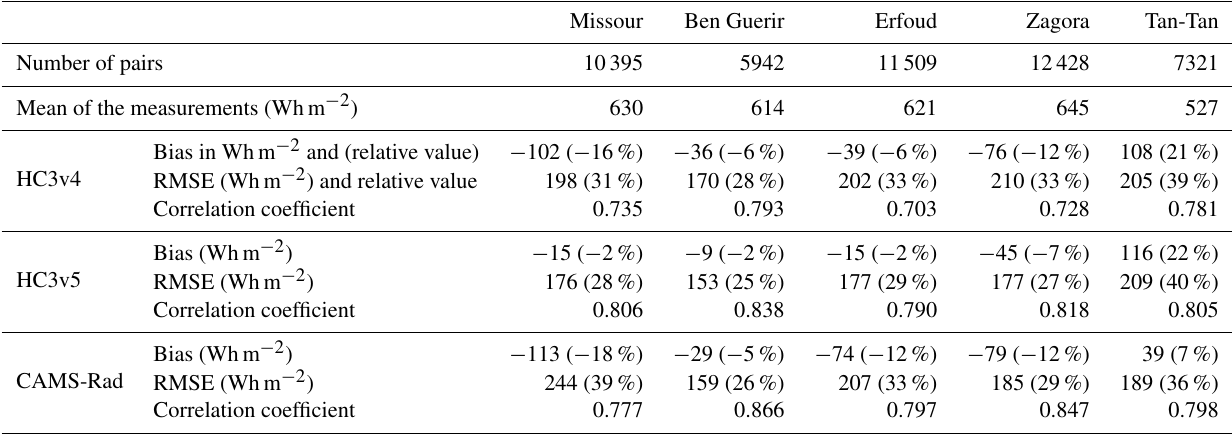
Table 3. Direct hourly SSI. Number of coincident data, mean of measurements, bias and RMSE and correlation coefficient for HC3v4, HC4v5 and CAMS-Rad. RMSE: root mean square error.